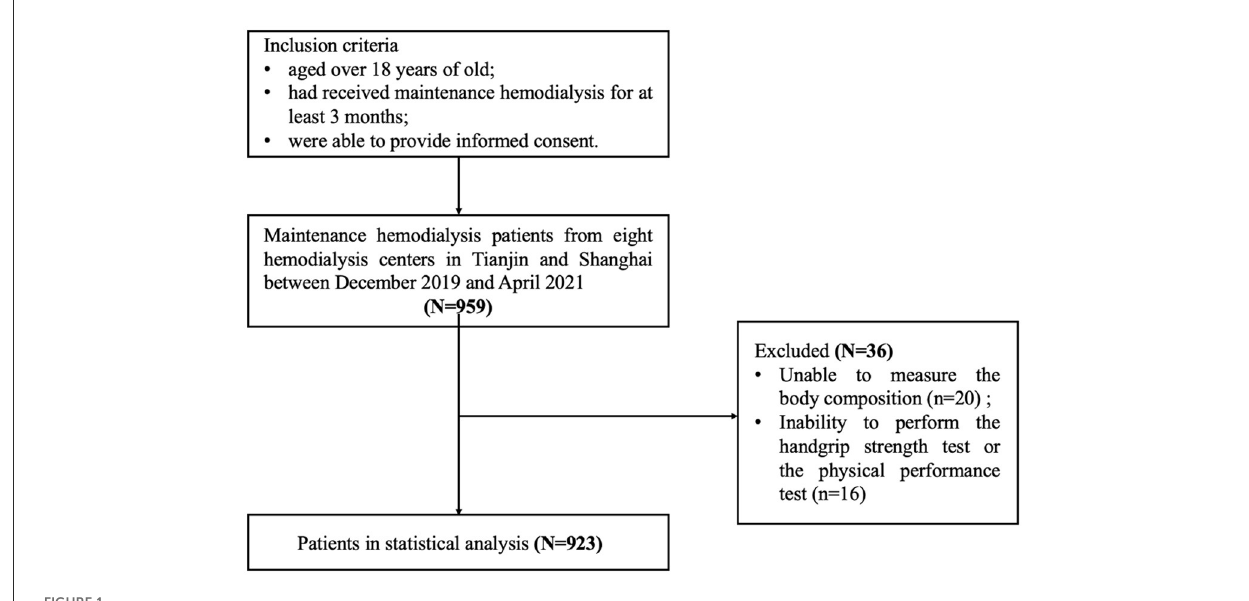
FIGURE1 Flowchart of study